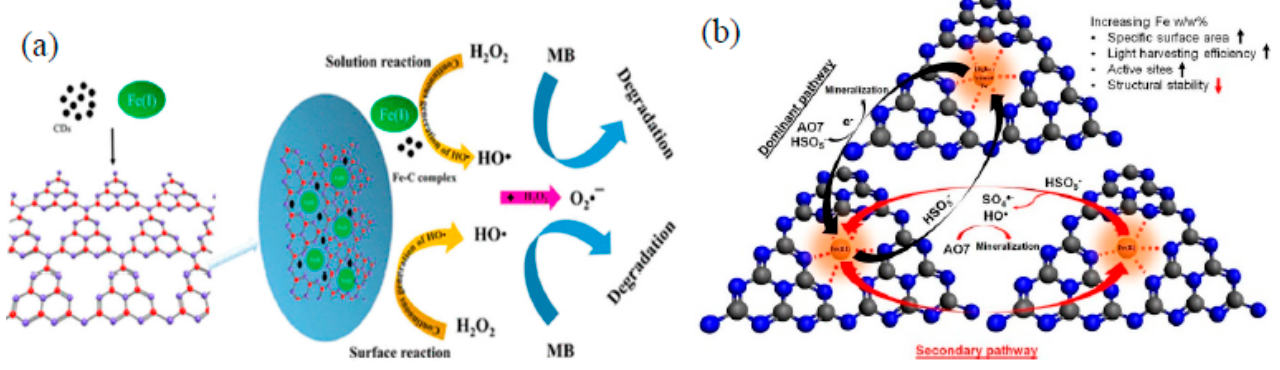
Figure 1. ( a ) Schematic illustration of the catalytic mechanism of g-C 3 N 4 /CDs/Fe(II) in the presence of H 2 O 2 , reprinted with permission from [68]. Copyright 2019 American Chemical Society. ( b ) Proposed mechanism of PMS activation by gCN-Fe 3 for AO7 removal, reprinted with permission from [83]. Copyright 2018 Elsevier.